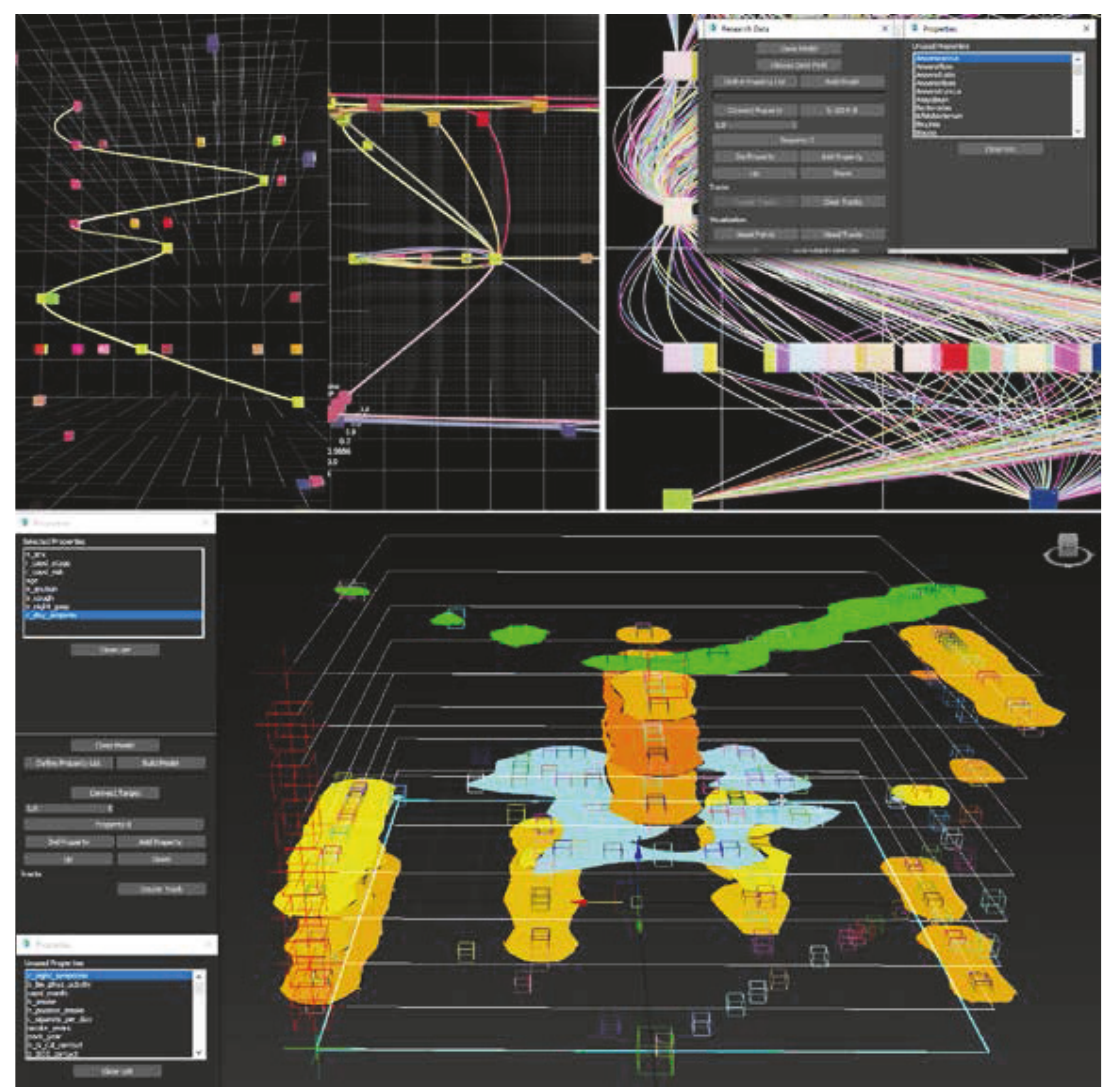
Fig. 2. States of a visual model and its properties management